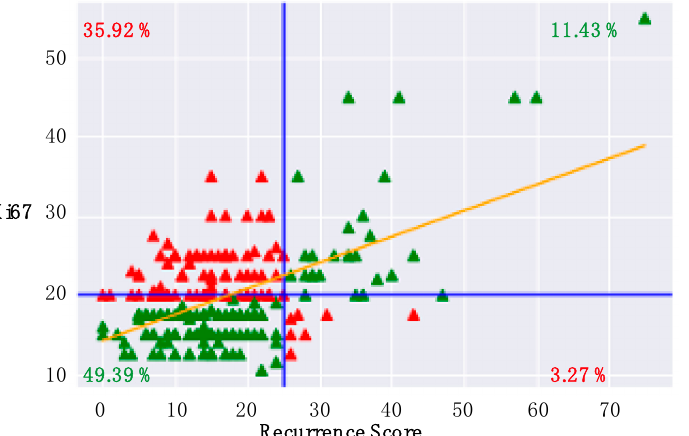
Figure 1. Correlation of Recurrence Score and Ki67: A clinical cut-off value for the Recurrence Score (RS) is ≥ 26 and for Ki67 is ≥ 20% (blue lines). Patients with concordant RS and Ki67 values are displayed in green. Discordant RS and Ki67 values are highlighted in red. The yellow line extrapolates the correlation coefficient (Rho = 0.54).